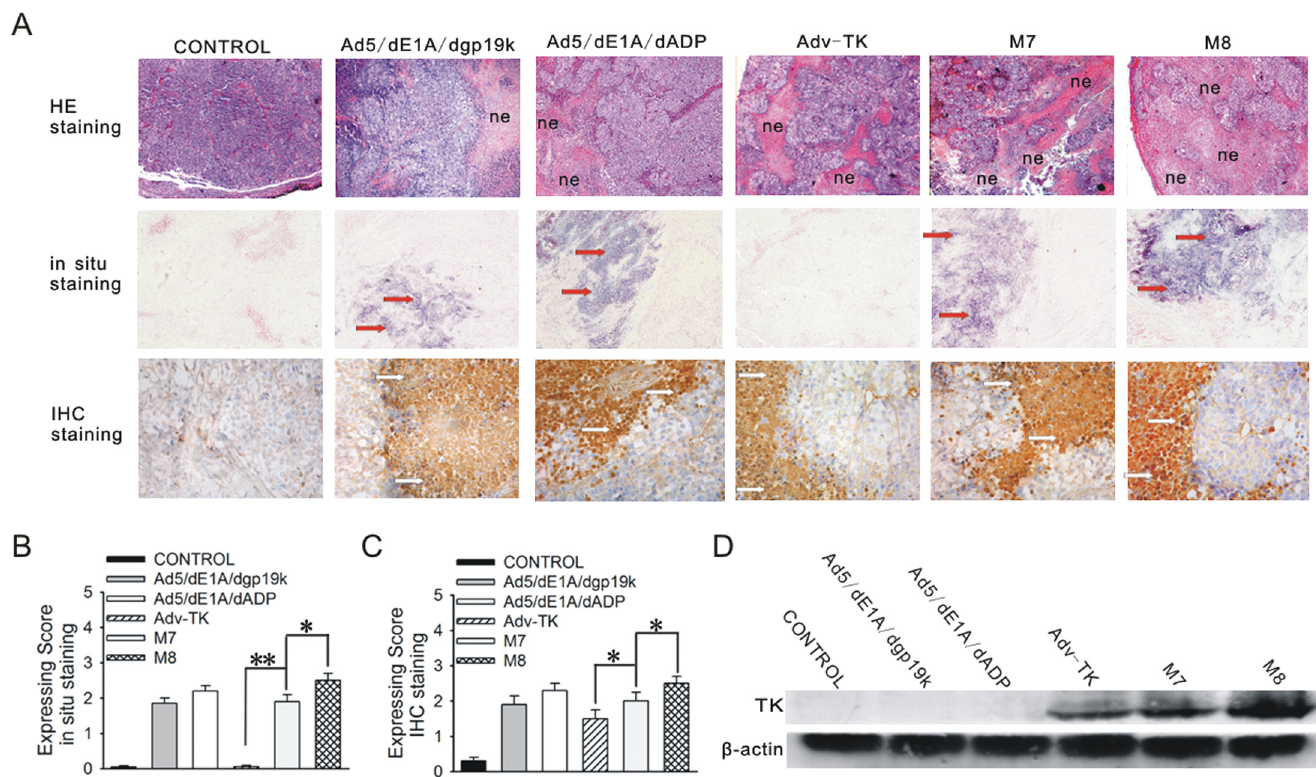
Fig 5. TK protein expression and viral titres of Adv-TK, M7 and M8 in orthotopic tumours. Orthotopic tumours were harvested at the time of study termination for hematoxylin and eosin (H&E) staining, western blot analysis, and immunohistochemical (IHC) and in situ hybridisation assays. A ) Orthotopic tumours were formalin-fixed and embedded in paraffin, and 5- μ m sections were prepared and stained with H&E. Viral replication was detected by in situ hybridisation with a digoxin-labelled viral fibre oligonucleotide probe complementary to the fibre coding region. Fibre production was determined by immunohistochemical staining using an anti-adenovirus mouse monoclonal antibody. Cells containing replicative virions were stained dark blue (red arrows), and those containing viral particles were stained brown (white arrows). B ) Horizontal bar graph showing the in situ hybridisation expression scores for viral fibre in tumours. C ) Horizontal bar graph showing immunohistochemical scores in tumours. D ) Protein was isolated from orthotopic tumours, and 40 μ g of total protein isolated from tumour tissues was subjected to western blot